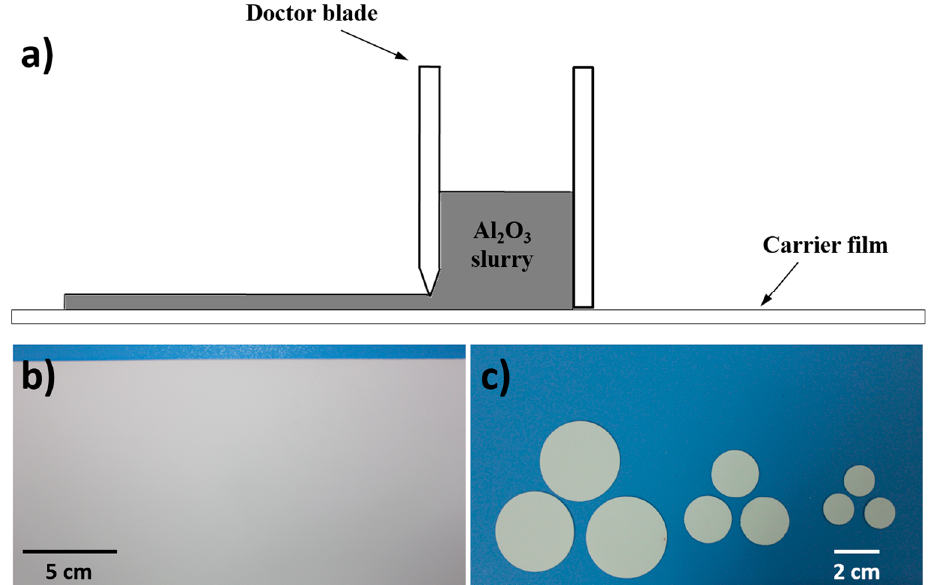
Figure 1. ( a ) Schematic illustration of the tape casting method, ( b ) alumina green tape after phase- inversion and drying, and ( c ) green samples after cutting.